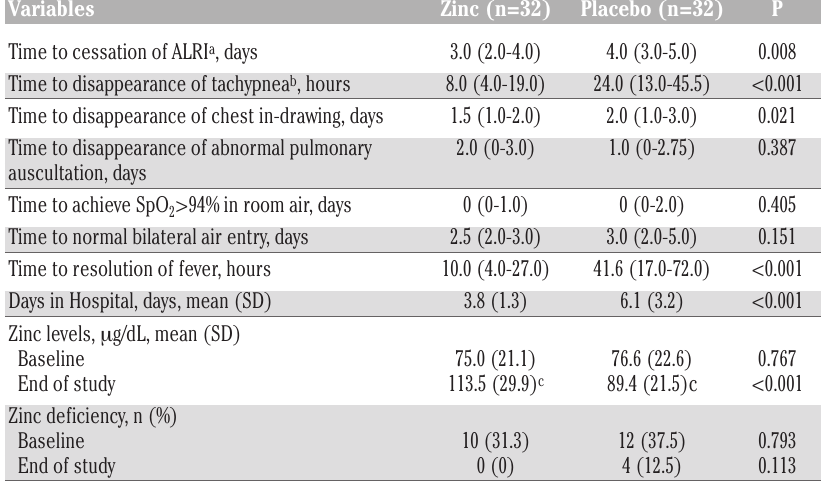
Table 2. Outcomes of zinc supplementation compared with placebo for children with acute lower respiratory tract